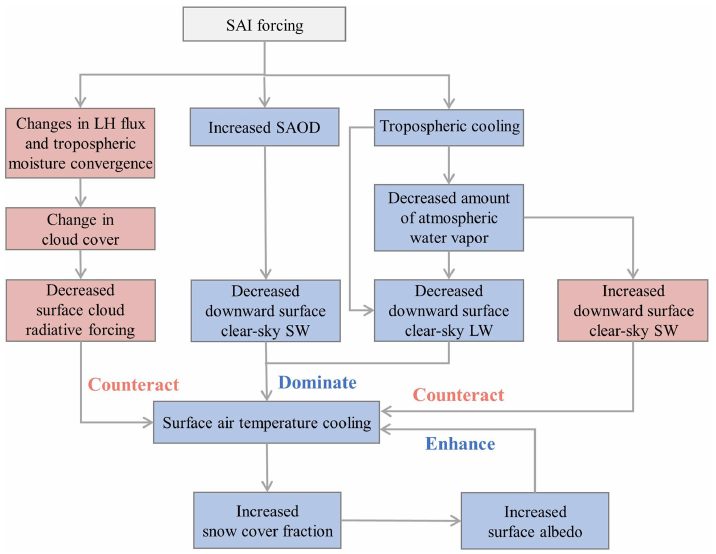
Figure 12. Schematic diagram illustrating how the relevant physical processes impact the downward surface radiation changes over China in response to the SAI forcing in the G4